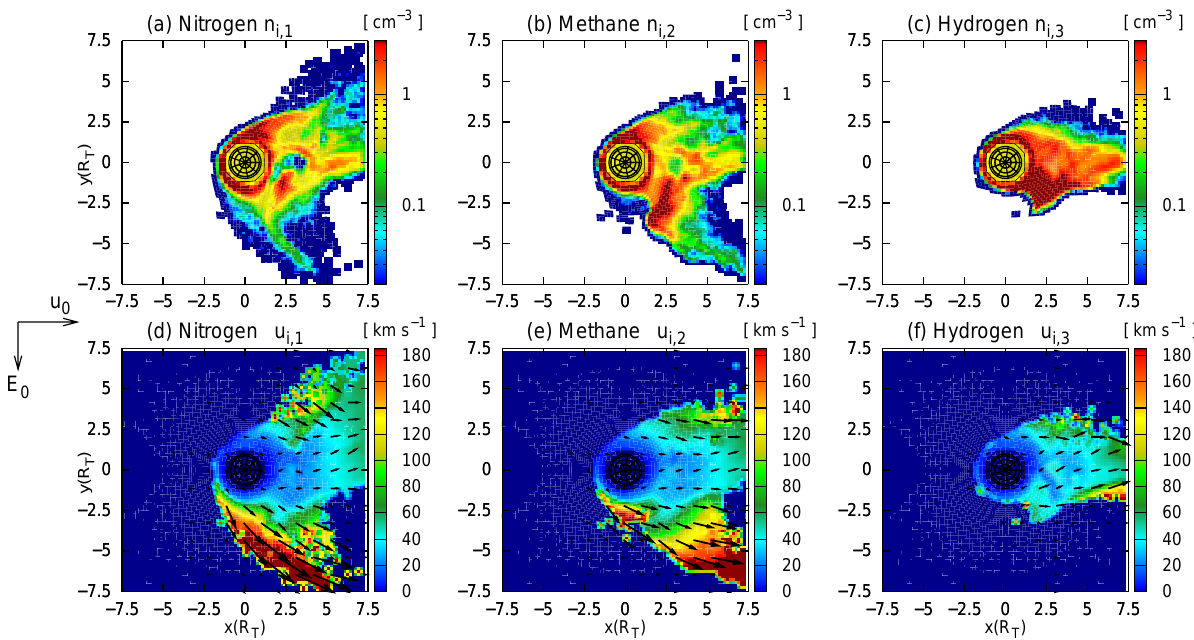
Fig. 6. Run #3 : Titan’s plasma environment under the influence of a periodic distortion according to eqs. (8) and (9). The period T = 2 π/ω of the distortion is T = 3500 δt , where 1333 δt correspond to the duration in which the magnetospheric plasma would pass through the simulation box one time. The plot shows the ionospheric plasma densities n and velocities u that correspond to the foregoing figure.